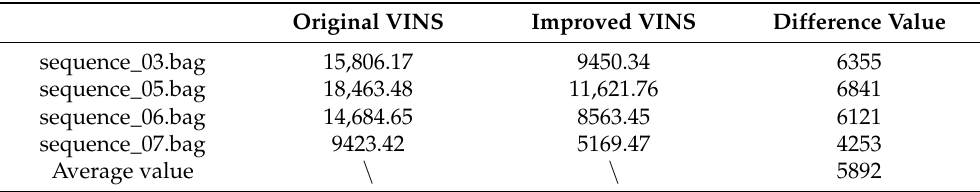
Table 17. Compare the marginalization speed between the original algorithm and the optimized algorithm in the underwater dataset (Unit: ms).